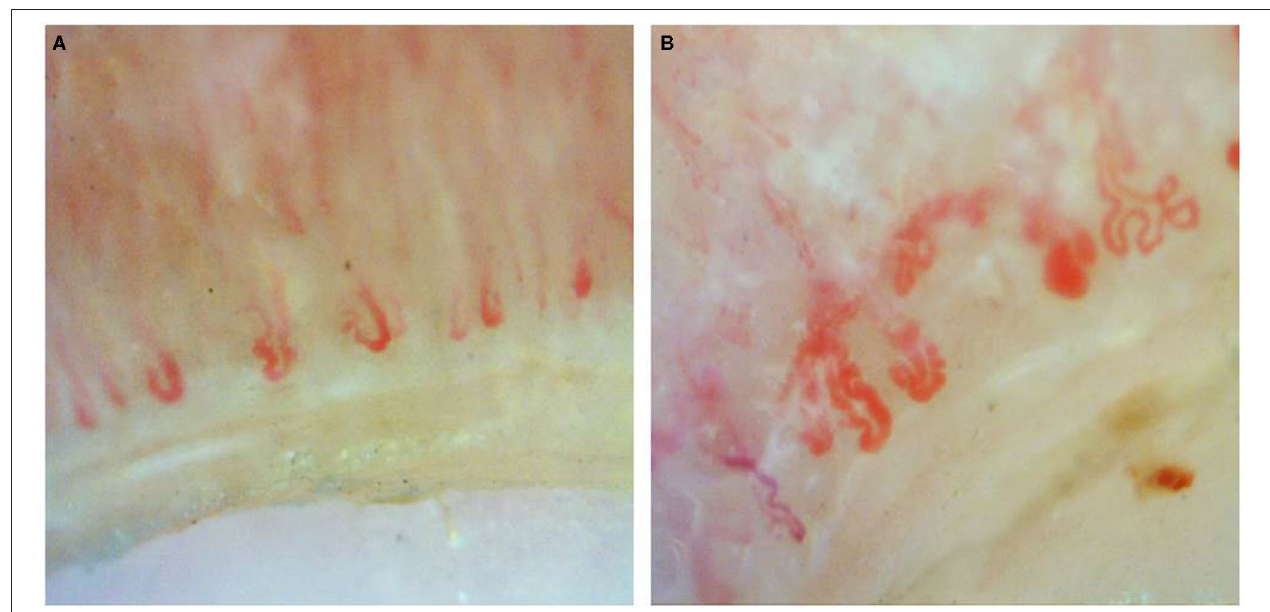
FIGURE 2 | Diameter index of onychoscopy: (A) enlarged capillaries and (B) giant capillaries.